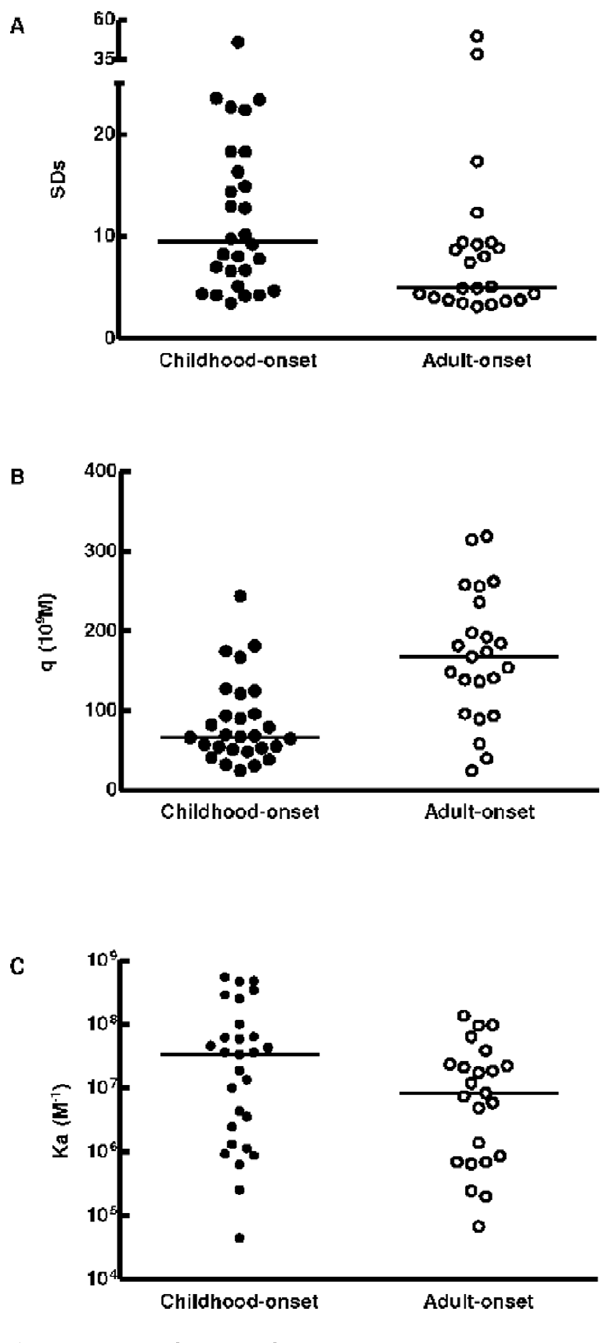
Figure 3. RBA and SPR results. (A) SD scores, (B) concentration (q) and (C) affinity constant (K a ) obtained from 28 newly diagnosed type 1 diabetic patients and 23 adult-onset diabetic patients. All the parameters differed significantly between both groups of patients (p , 0.05).